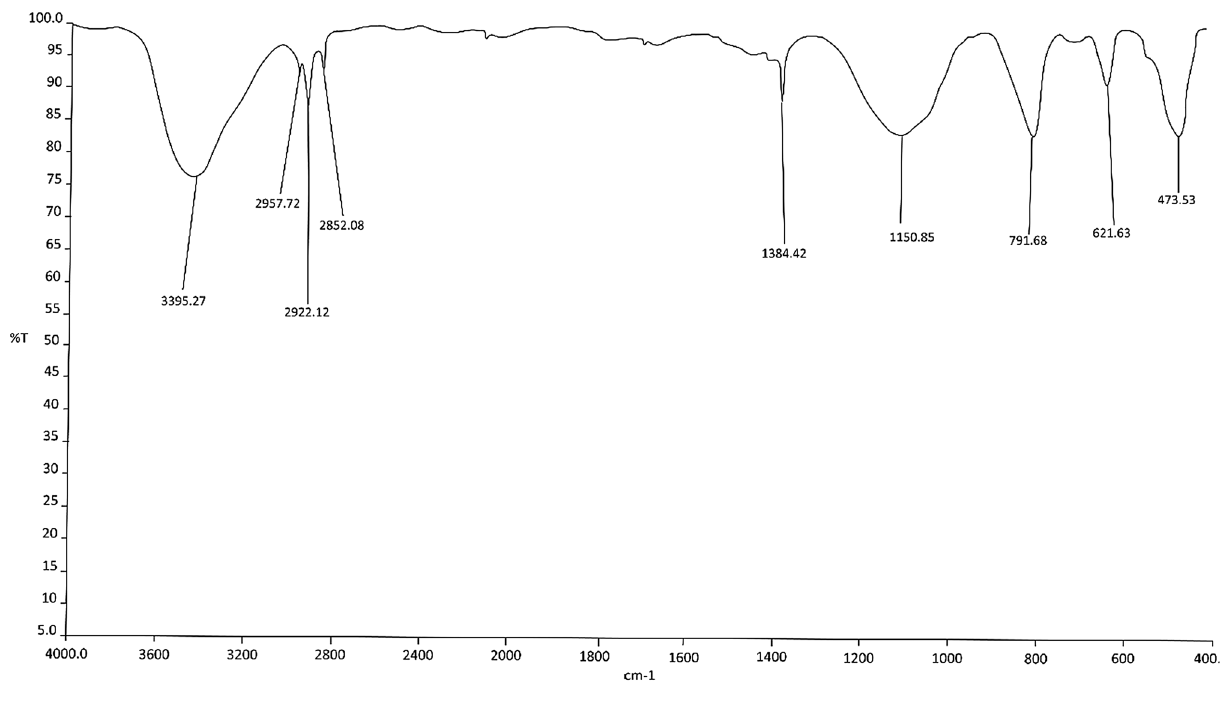
Fig. 2 FTIR absorption spectrum of BFA